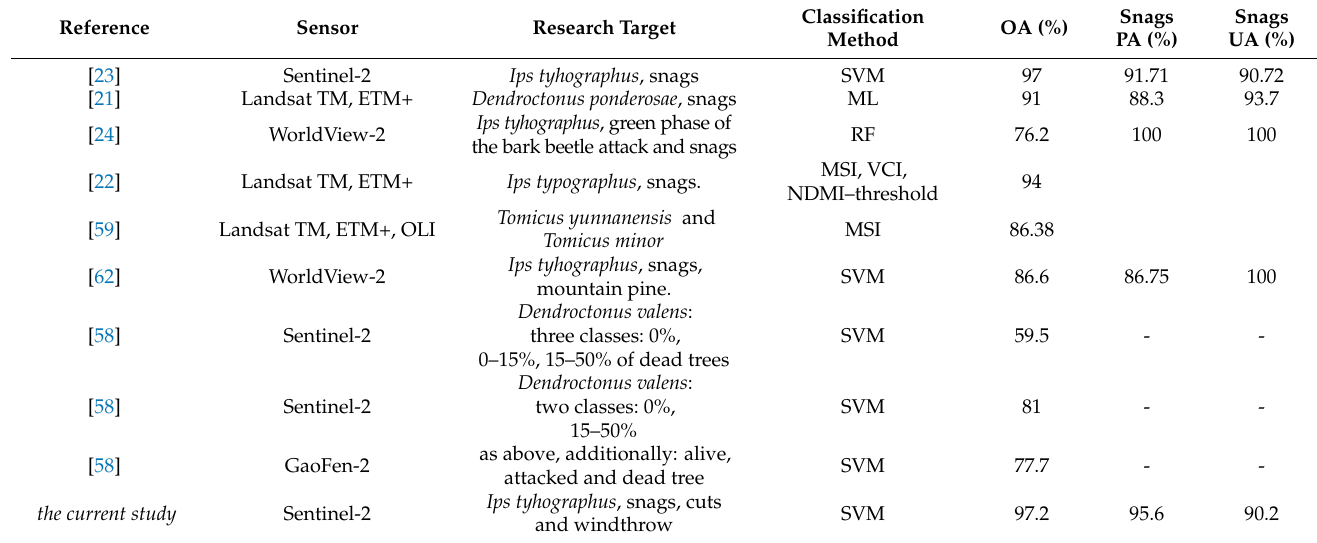
Table 8. Classification of the gradation of cambiophagous insect’s assessment of results. Explanation: OA—Overall Accuracy; PA —Producer Accuracy; UA—User